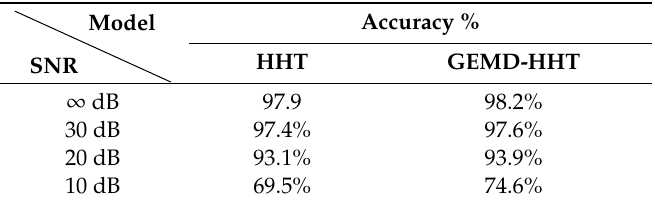
Table 4. The classification accuracy of bearing damages.